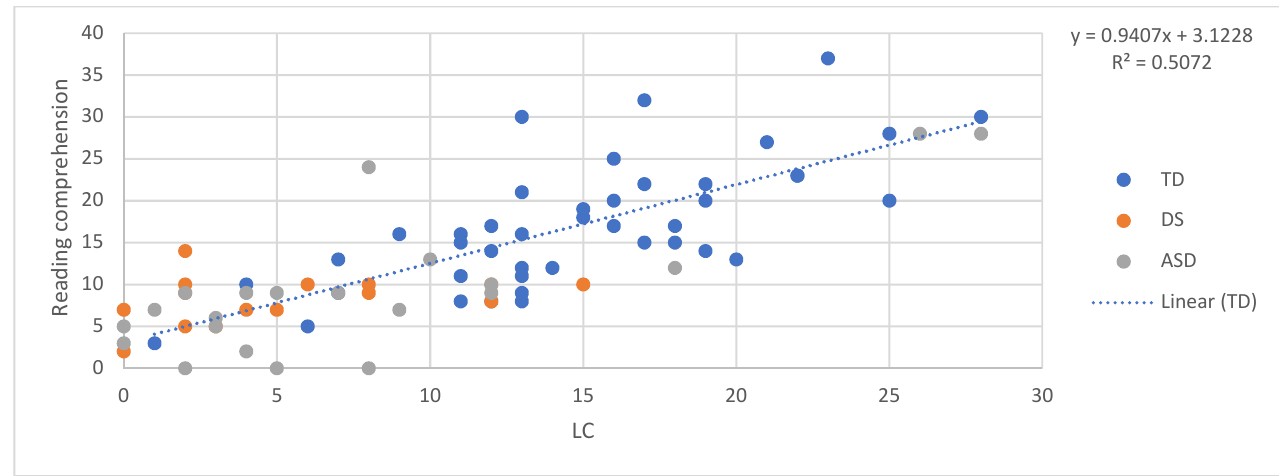
Figure 3. Receptive vocabulary predicting reading comprehension.